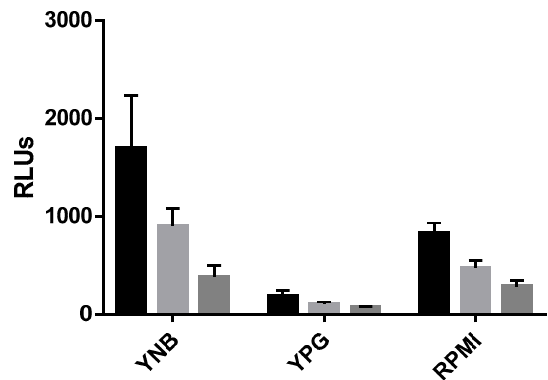
Figure 3. Light emission of R7B_luc in different growth media. YNB medium was inoculated with 2 × 10 5 spores/mL of R7B_luc, incubated for 16 h, and then replaced by fresh YNB, YPG, or RPMI, respectively. Light emission was induced by addition of substrate (luciferin 1:5) 3 h after medium exchange and detected by using a plate reader. RLUs were determined immediately after addition of substrate (black bars), 10 min (light grey bars) and 30 min (dark grey bars) after the addition of substrate. Error bars indicate standard deviation. RLUs emitted in each media were significantly different from the other media tested (Two-way analysis of variance (ANOVA), p < 0.05).